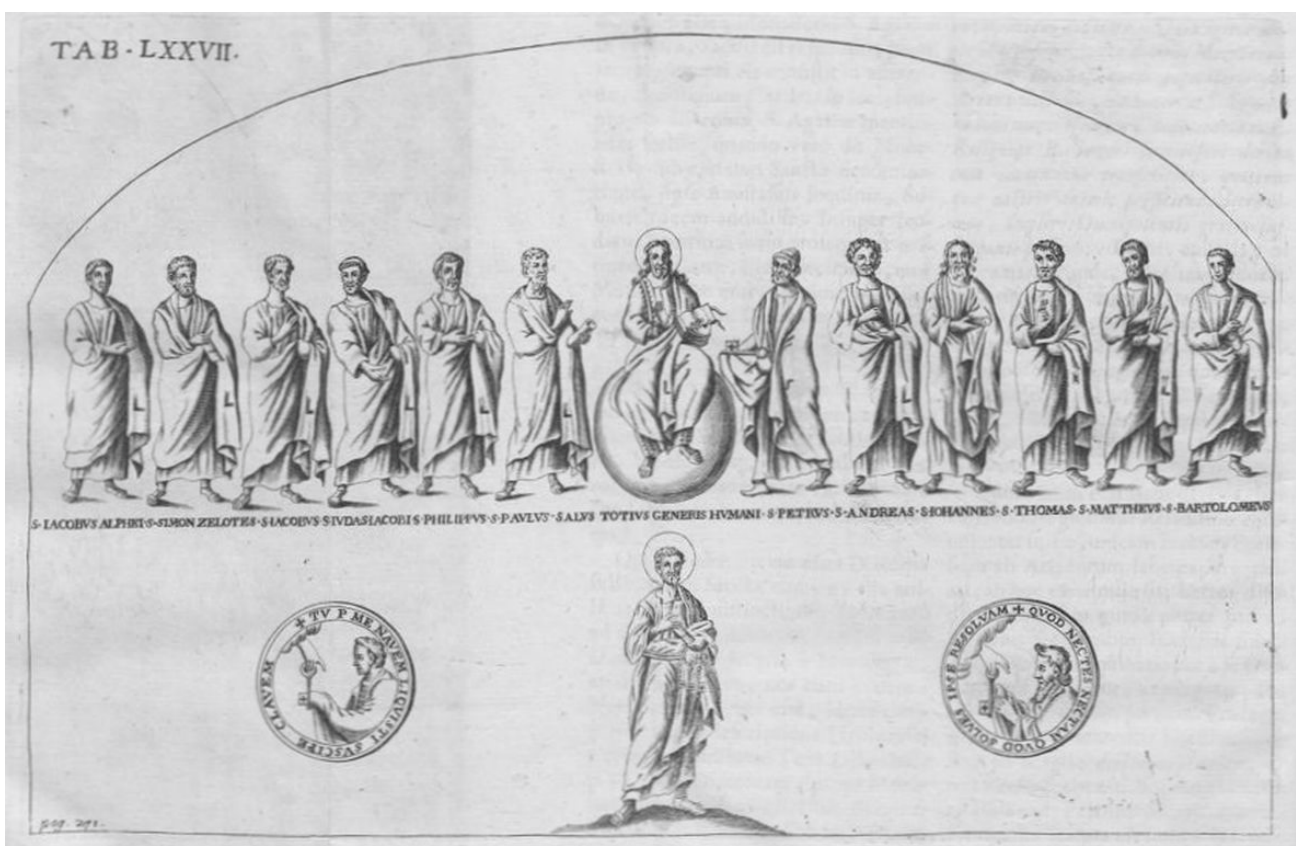
Figure 1. Drawing of the lost decoration of the apse of the basilica of Sant’Agata dei Goti at Rome (after Ciampini 1690, t. 77).